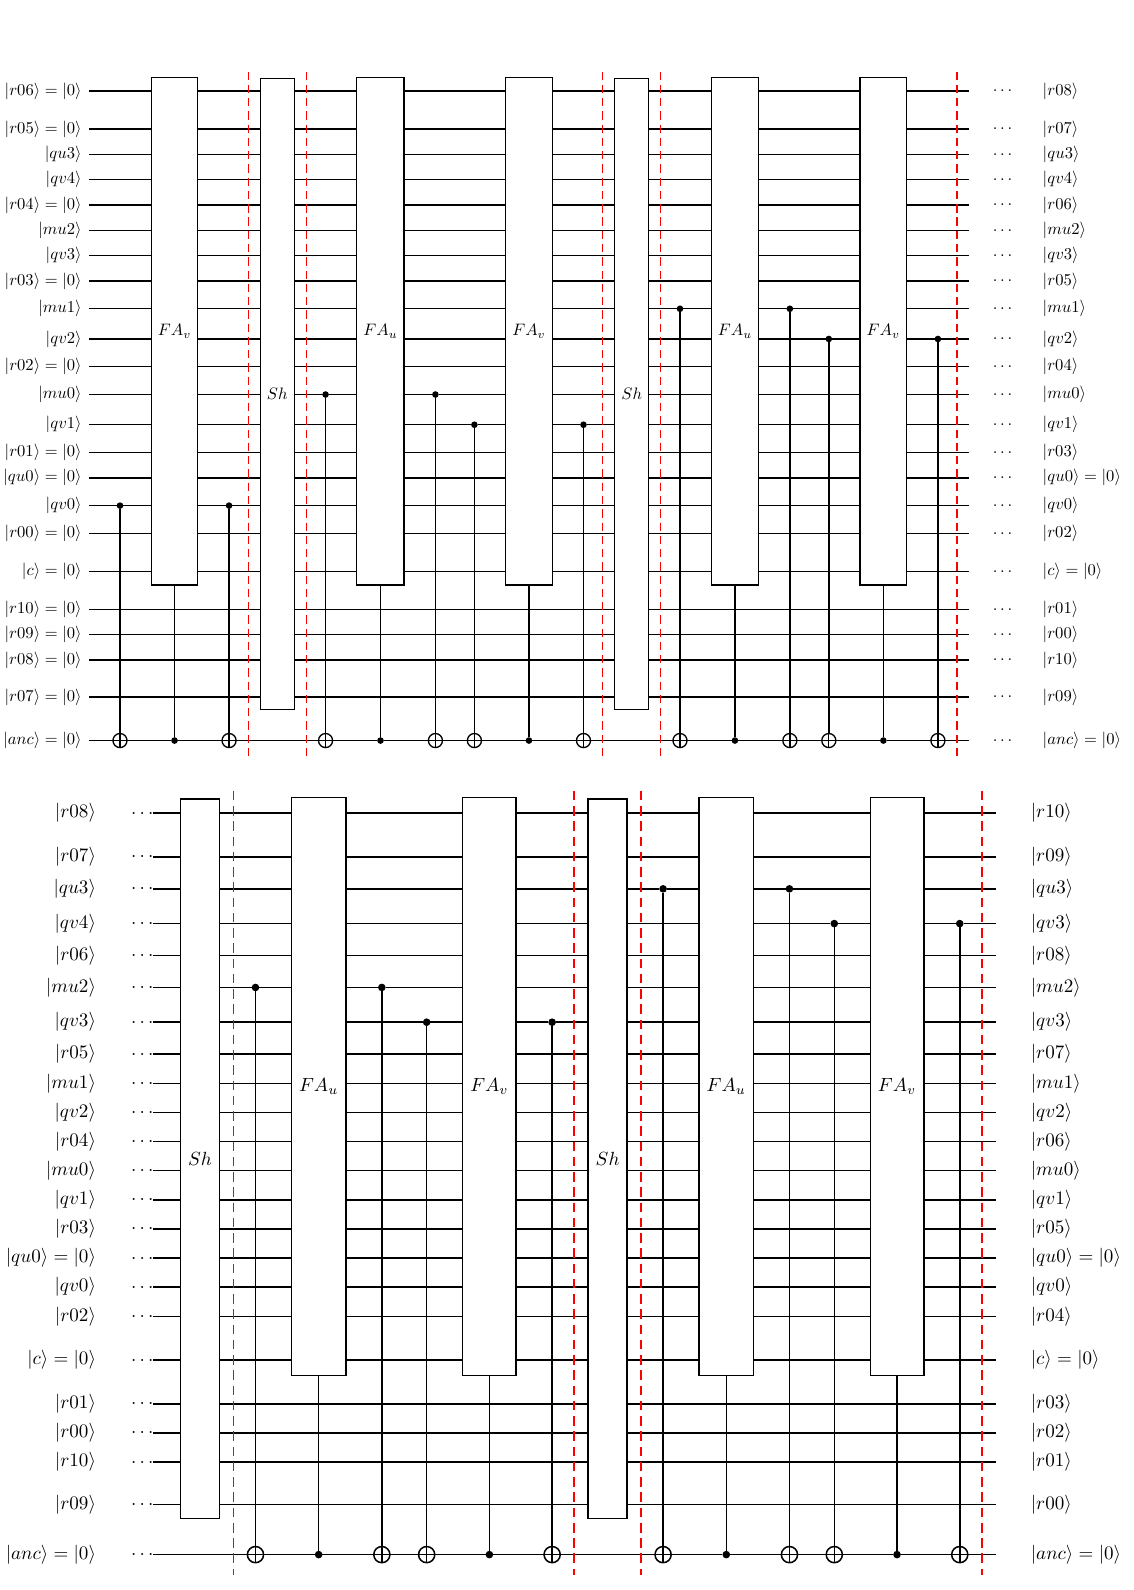
Figure 13. Quantum circuit defining SQ 5 used in the computation of u 2 + v 2 . Scaled velocity components u and v are represented as floating-point numbers with four mantissa qubits ( N M = 4) and three exponent qubits ( N E = 3). Circuit uses modified 6-qubit Cuccaro full adders ( FA u and FA v ) with 11-qubit results register. Sh performs a ’downward’ shift of the results